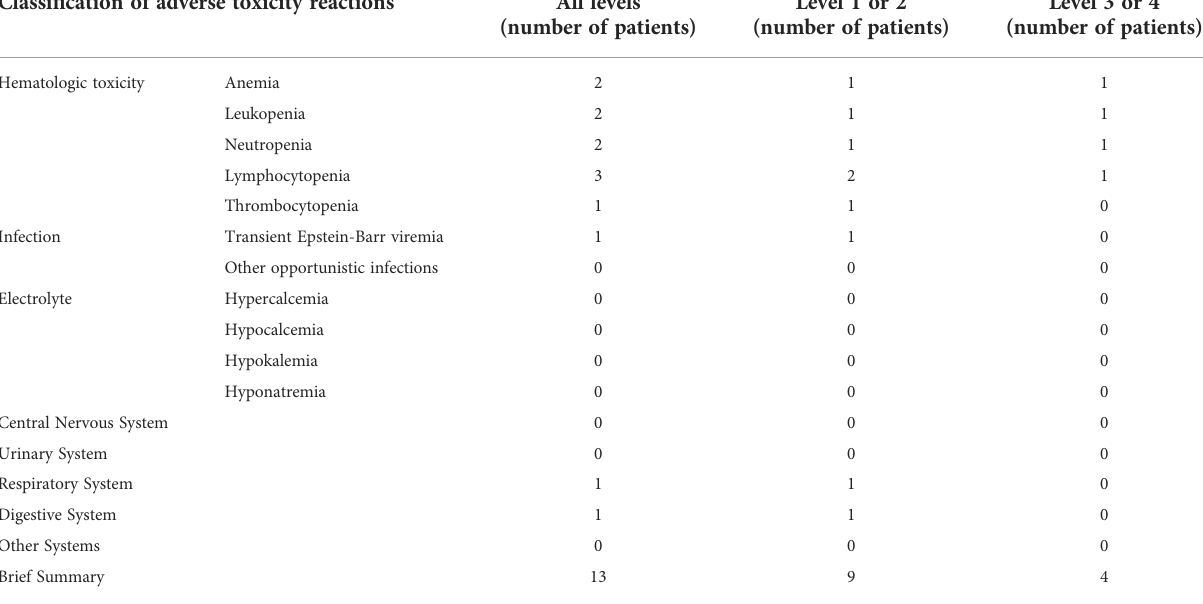
TABLE 1 Toxicity pro fi le of CD4-IL15/IL15sushi CAR T cells. Classi fi cation of adverse toxicity reactions All levels